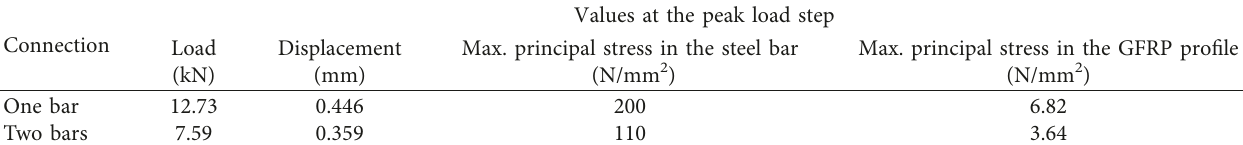
Table 4: 2D FEM results.